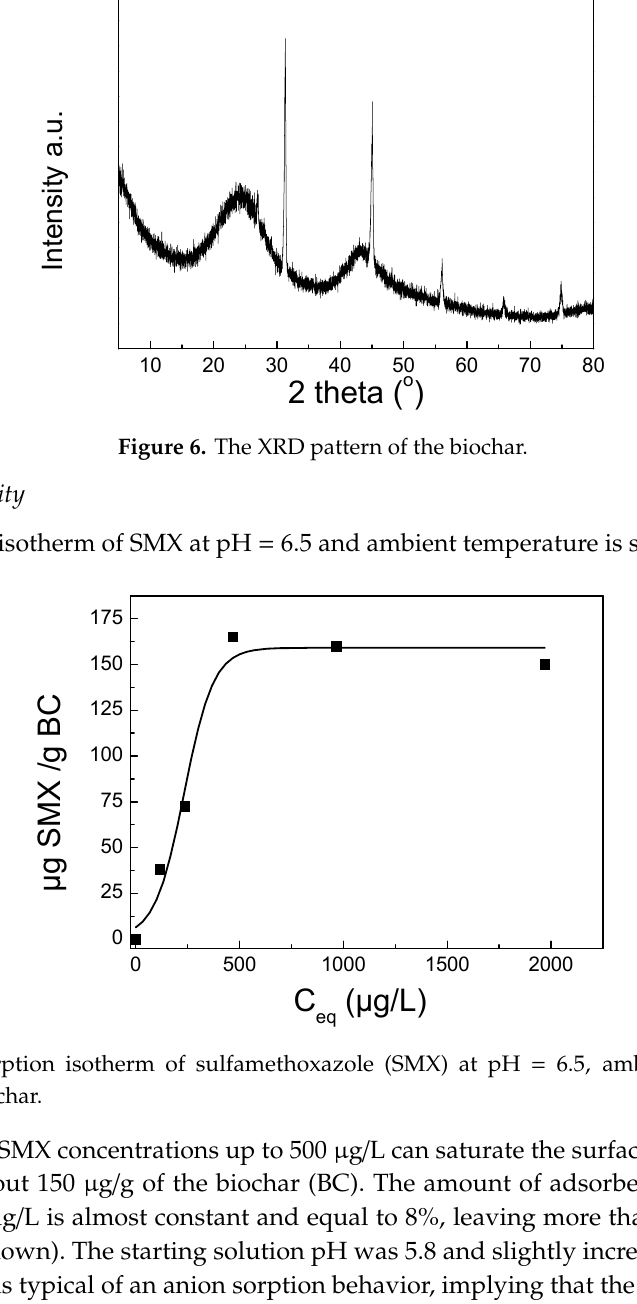
Figure 5. The FTIR spectrum of the biochar.